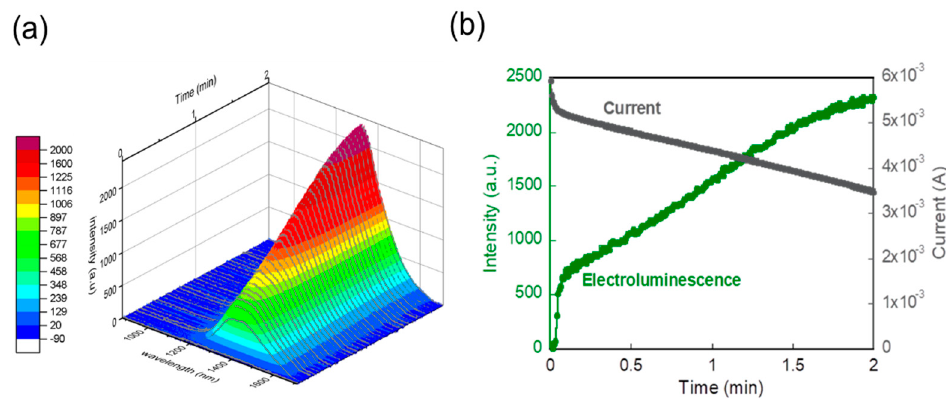
Figure 2. ( a ) Plots of electroluminescence (EL) spectra as a function of time during light emission application of 1.5 V to the indium tin oxide (ITO) side. ( b ) Plots of current and EL intensity as a under application of 1.5 V to the indium tin oxide ( ITO) side. ( b ) Plots of current and EL intensity as a function of time.